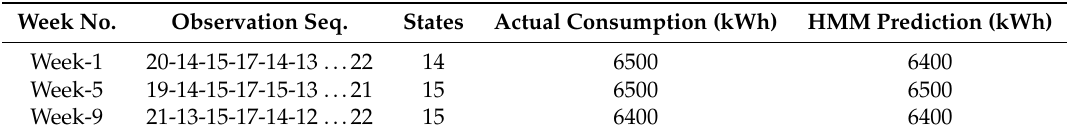
Table 4. Details of three sample cases in weekly data.